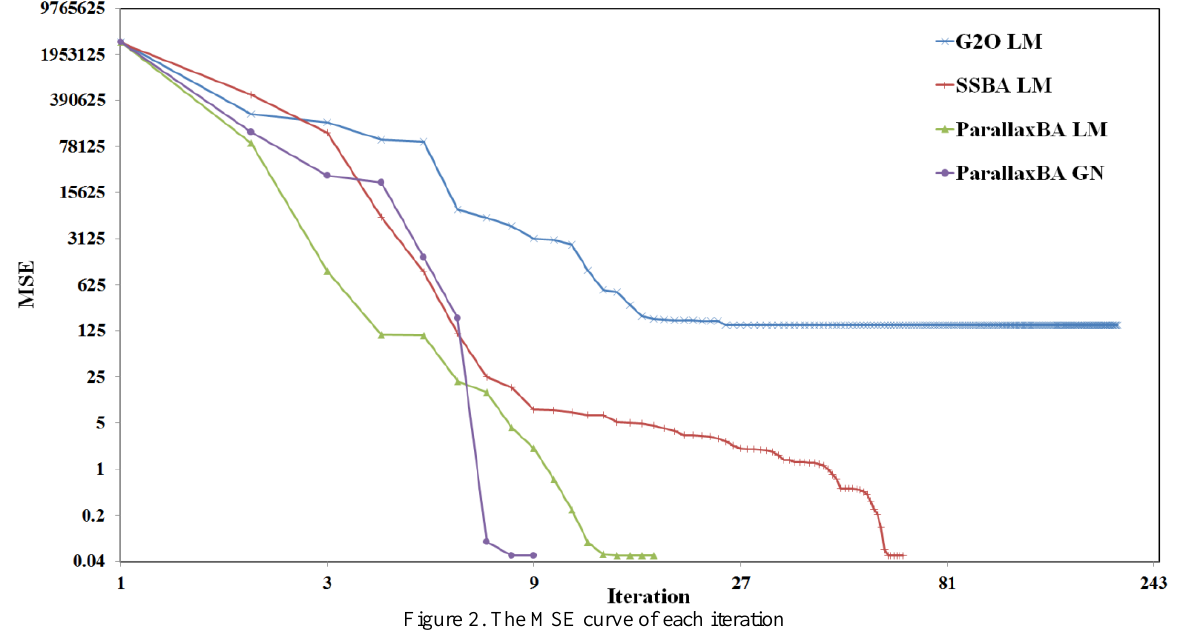
Figure 2. The MSE curve of each iteration